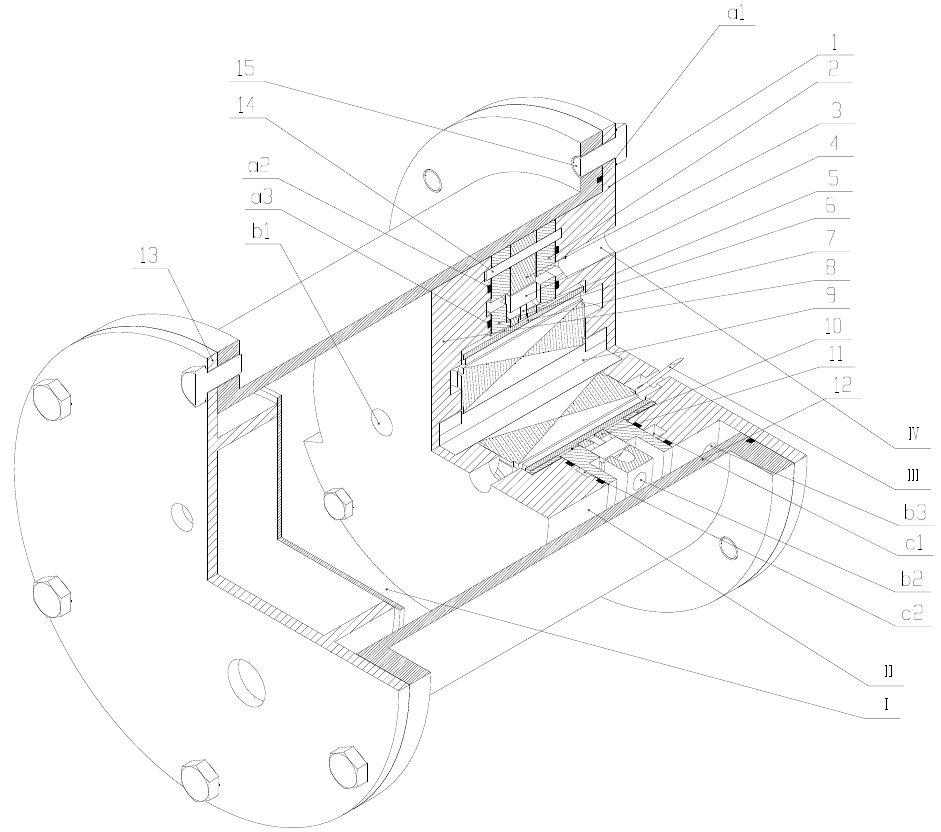
Figure 5. The proposed IEHVP, 1-Front end cover, 2-Front oil distribution side plate, 3-vane pump stator, 4-blade, 5-pin, 6-rear oil distribution side plate, 7-Outer rotor motor, 8-Rear cover, 9-support shaft, 10-Needle bearing, 11-Vane pump rotor, 12-oil tank shell, 13-Fuel tank cap, 14-Locating pin, 15-Flange Bolt, a1-flange sealing ring, a2&a3-pump body sealing ring, b1-Oil hole in the rear end cover, b2-Vane pump stator oil through-hole, b3-Front end cover oil hole, c1&c2-front and rear end cover pressure compensation oil groove, I-Inner cavity of fuel tank, II-Sector suction area, III-Power cord extension port, IV-Vane pump oil outlet.